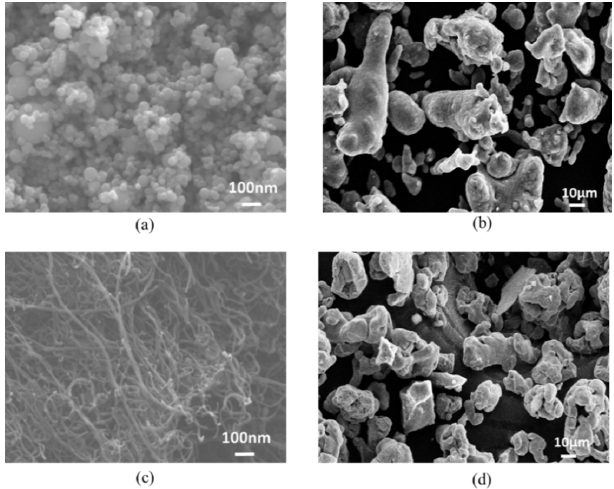
Figure 1. SEM images of the as-received powders: ( a ) Fe nanopowders (nFe); ( b ) Al powders; ( c ) multi-walled carbon nanotube (MWCNT) powders and ( d ) Fe microparticles (mFe).